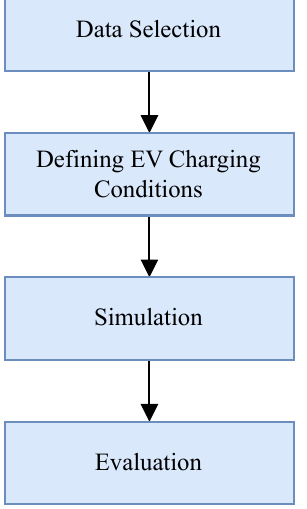
Figure 2. Research